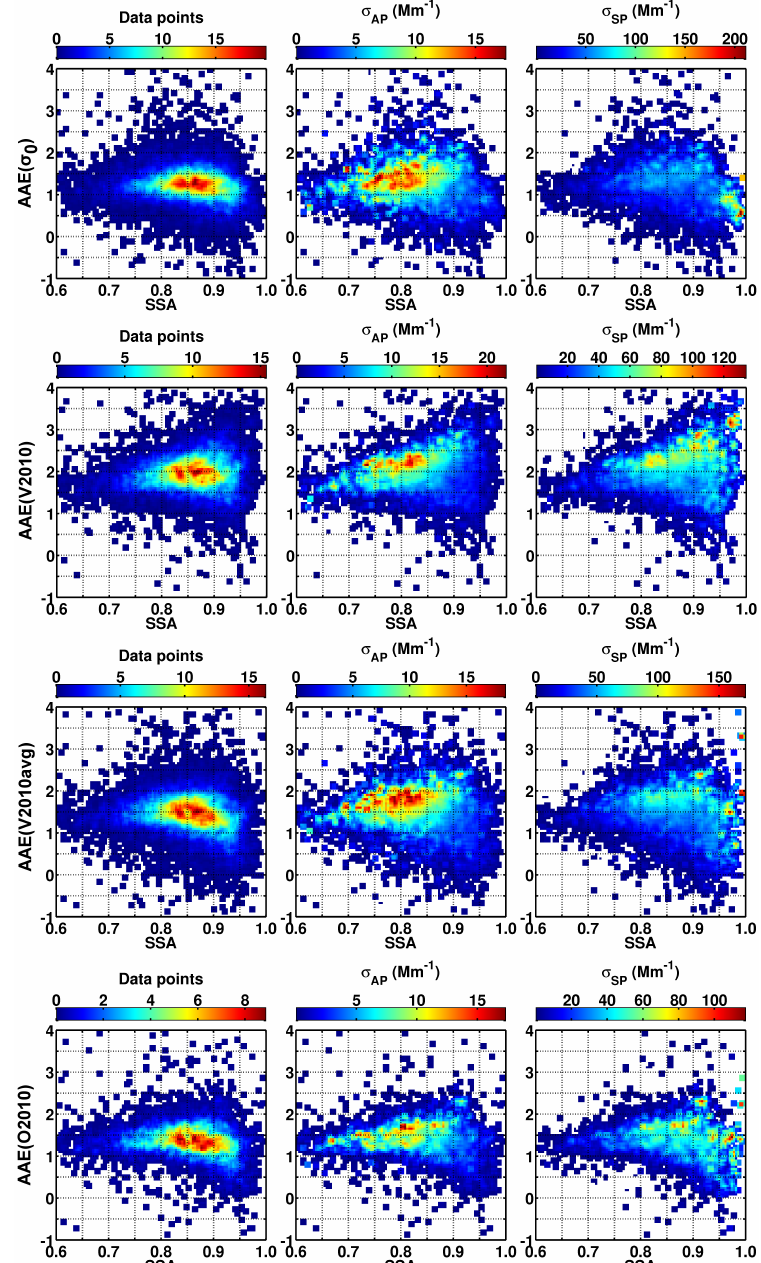
Figure 7. AAE as a function of SSA, colour coded with the number of data points σ AP and σ SP . The SSA was calculated using MAAP and Nephelometer data at 637nm wavelength to fix the x axis for all subplots. The AAE ( y axis) was calculated for σ 0 (first rows), V2010 (second row), V2010avg (third row) and for the O2010 (bottom row) correction. MAAP data was used for colour coding σ AP in the middle